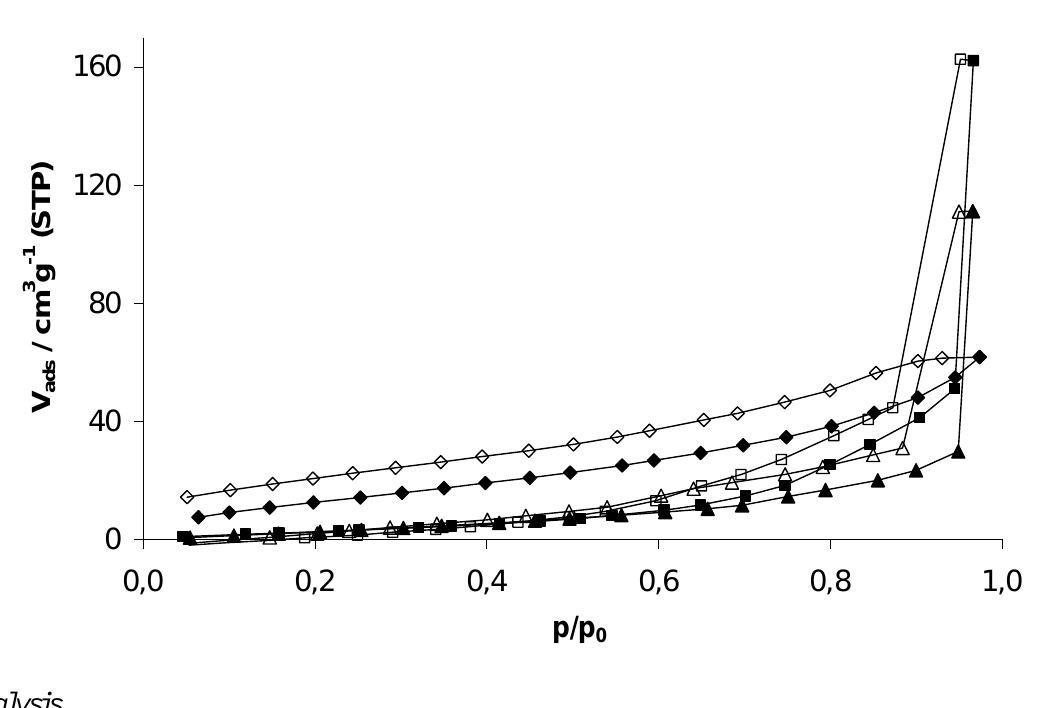
Figure 7. Water vapor physisorption isotherms of EOF-3 (diamonds), -4 (squares) and -5 (triangles) measured at 298